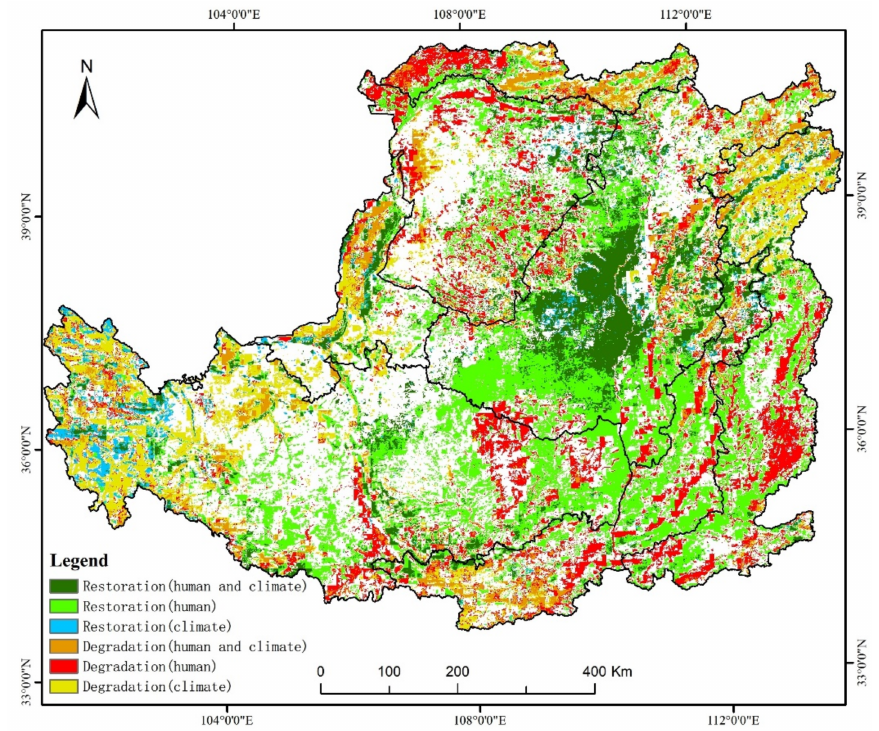
Figure 11. Distribution of driving factors of the significant restoration and significant degradation of vegetation quality on the Loess Plateau from 1990 to